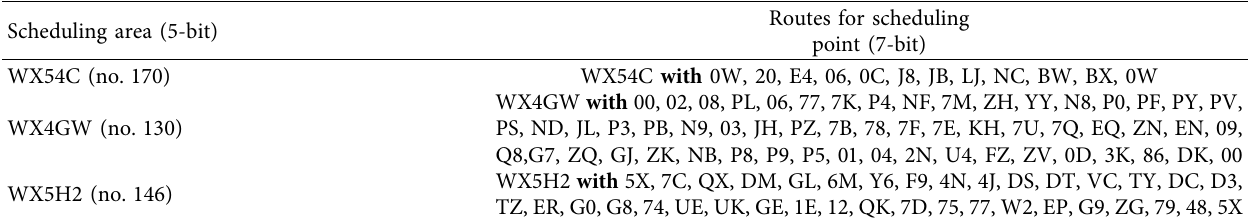
Table 6: Te mapped scheduling results with examples of route one (Table